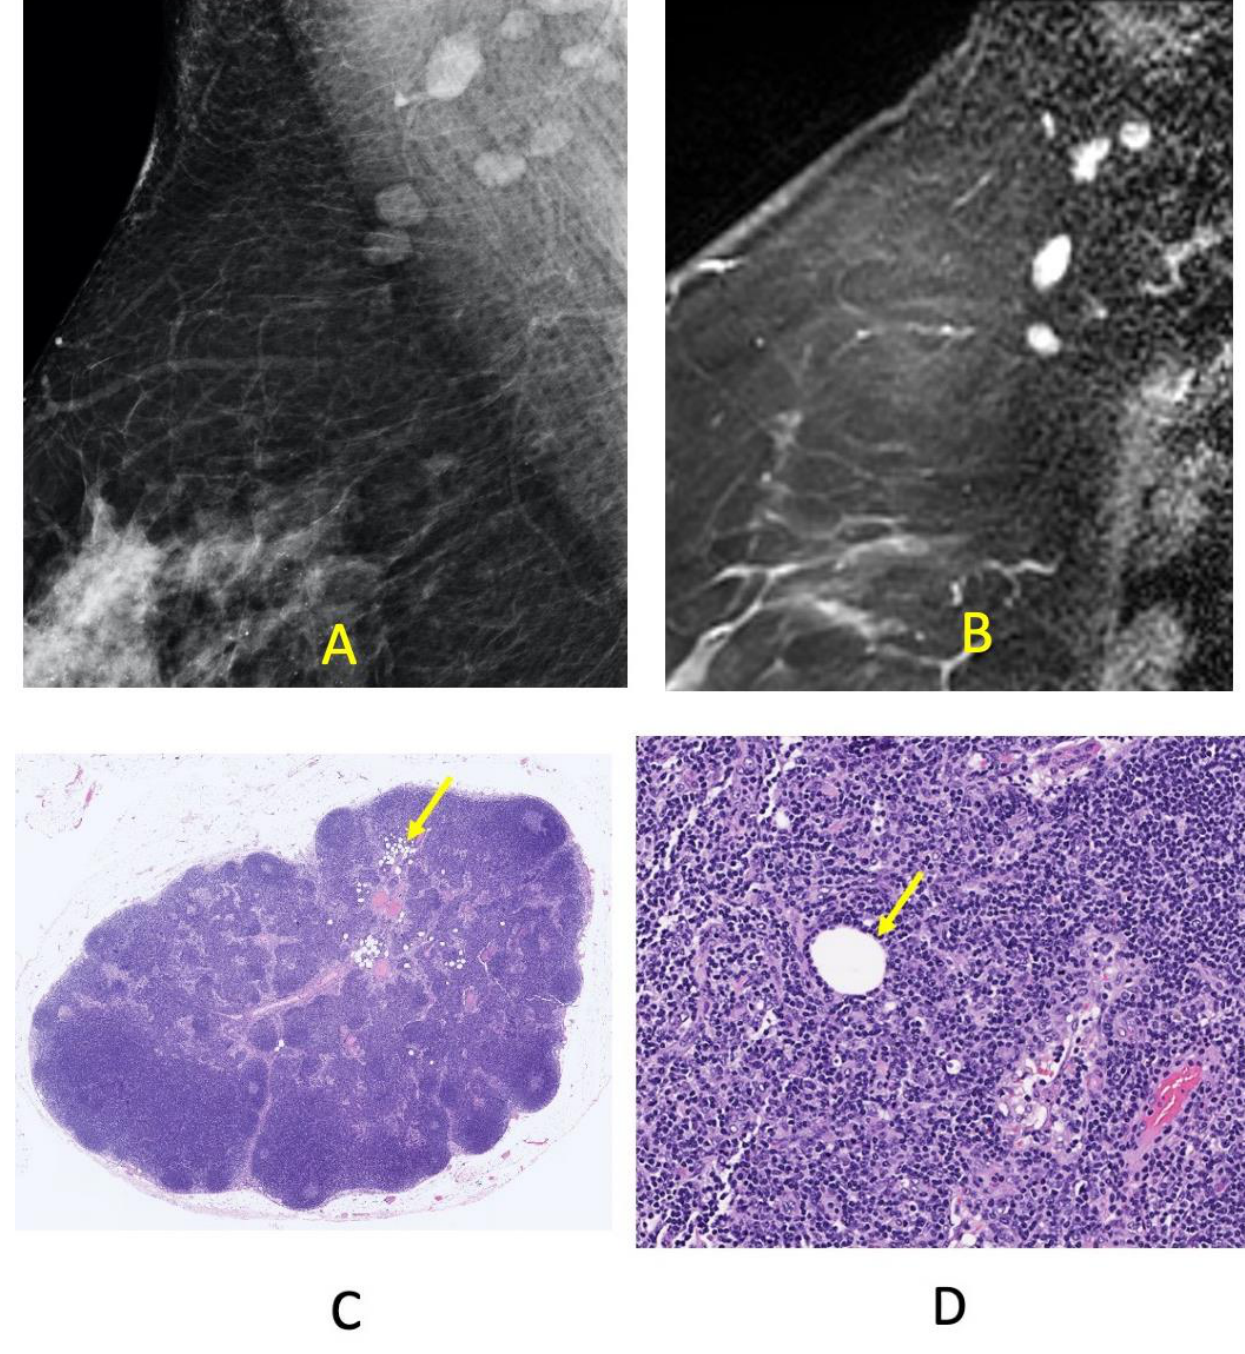
Figure 2. Normal right axillary lymph nodes, the largest measuring 13 mm, in a 62-year-old female with node negative right breast cancer. Normal nodes are visualized within the axilla on a right breast medio-lateral oblique mammogram ( A ), and on a sagittal contrast-enhanced right breast MRI ( B ). The histology of a sentinel node obtained at the time of breast cancer surgery confirms normal lymph node morphology with minimal fat. Rare patches of adipocytes are present; however, the lymph node architecture and cortical thickness are largely preserved (H&E, 1× magnification) ( C ). A single adipocyte is pictured within a background of lymphocytes and small capillaries (H&E, 20× magnification) ( D ).